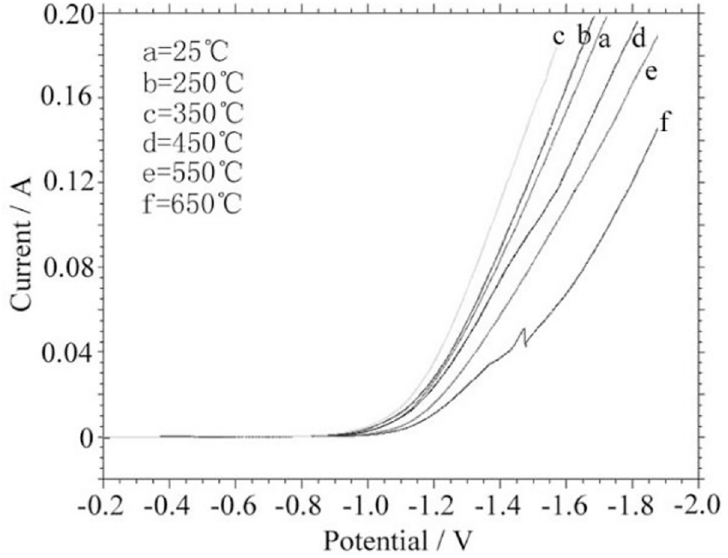
Fig 5. Steady electrode polarization patterns of the deposited after heat